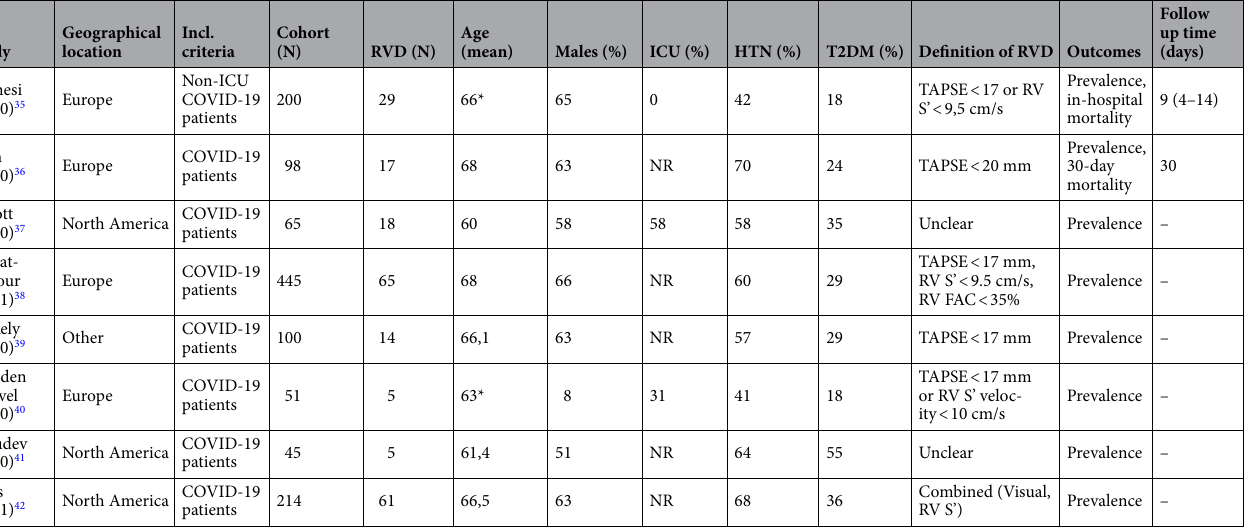
Table 1. Baseline characteristics of the included studies. ARDS acute respiratory distress syndrome, CVD cardiovascular disease, HTN hypertension, ICU intensive care unit, NR not reported, PASP pulmonary arterial systolic pressure, RVD right ventricular dysfunction, RVEF right ventricle ejection fraction, RV FAC right ventricle fractional area change, RV FWS right ventricle free wall strain, RV S ’ right ventricle systolic